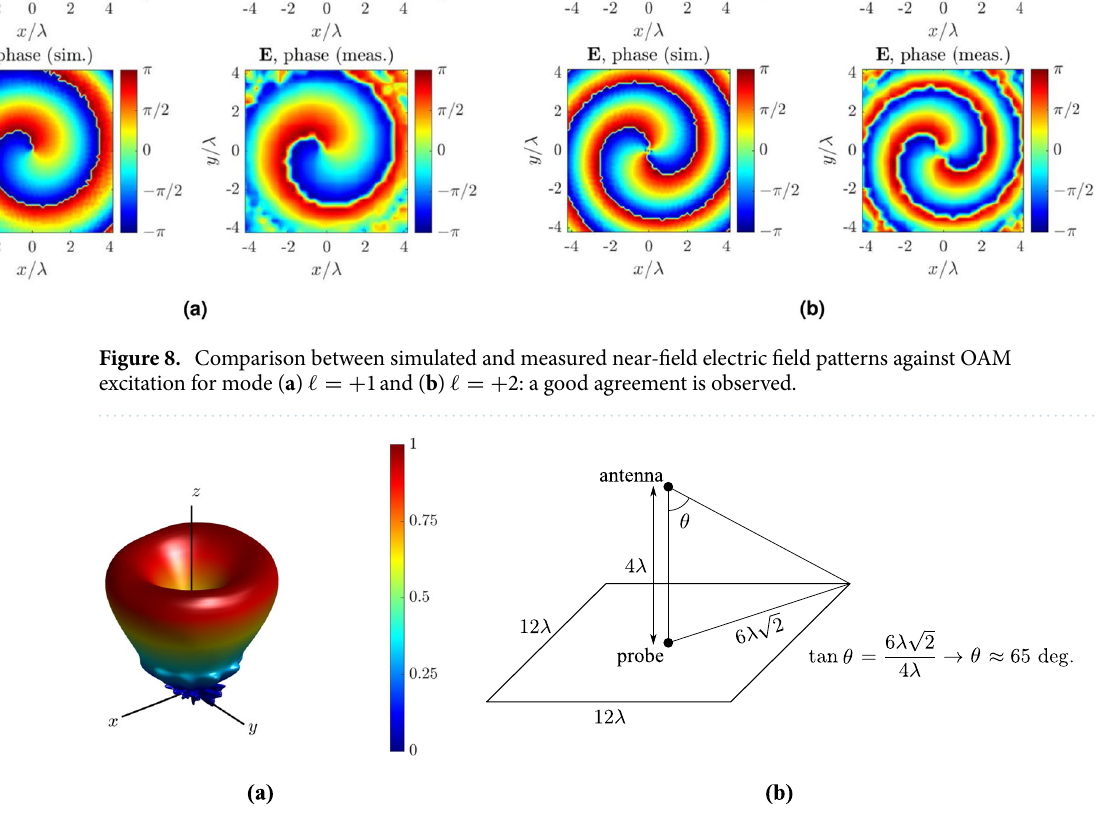
Figure 9. Normalized far-field radiation pattern (3D representation) of the circular antenna array, generated by the near-field measurements, estimated through the near- to far-field transformation (based on the asymptotic evaluation method), for the first OAM mode ( ℓ = 1 ). Also presented the maximum angle that the normalized radiation pattern is valid, which is from − 65 ◦ to 65 ◦ .